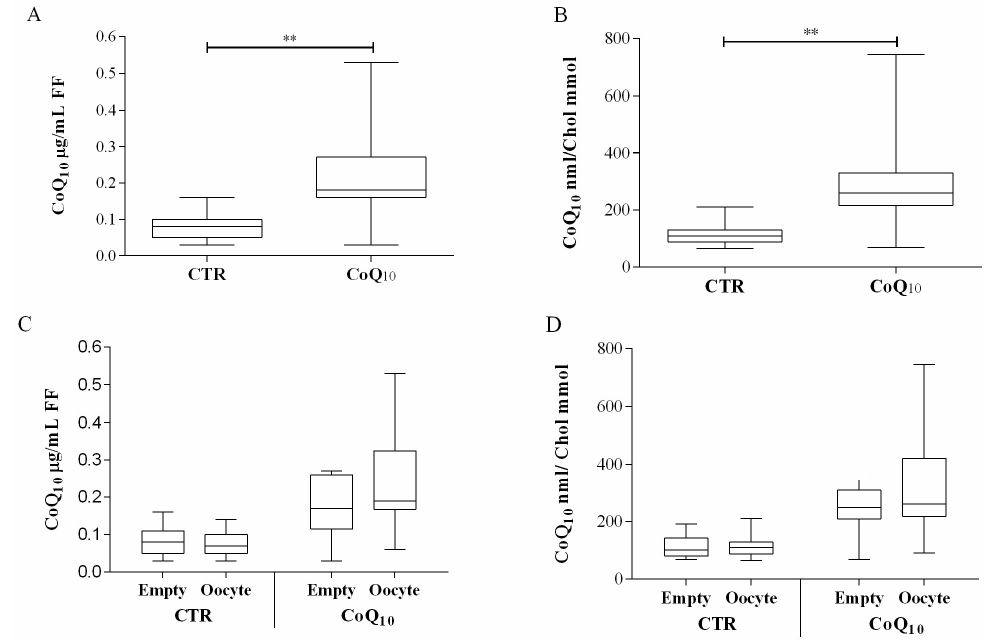
Figure 1. Follicular fluid (FF) coenzyme Q10 content in control (CTR n = 51) and supplemented IVF patients (CoQ10 n = 69). CoQ10 is expressed both per volume of follicular fluid as µ g CoQ10/mL FF ( A ) or normalized for cholesterol content as nmol CoQ10/mmol Chol ( B ). Sub analysis in relation to oocyte content as µ g CoQ10/mL FF ( C ) or normalized for cholesterol content nmol CoQ10/mmol Chol ( D ). ** p < 0.01. (oocyte containing follicles n = 30 CTR; n = 44CoQ).